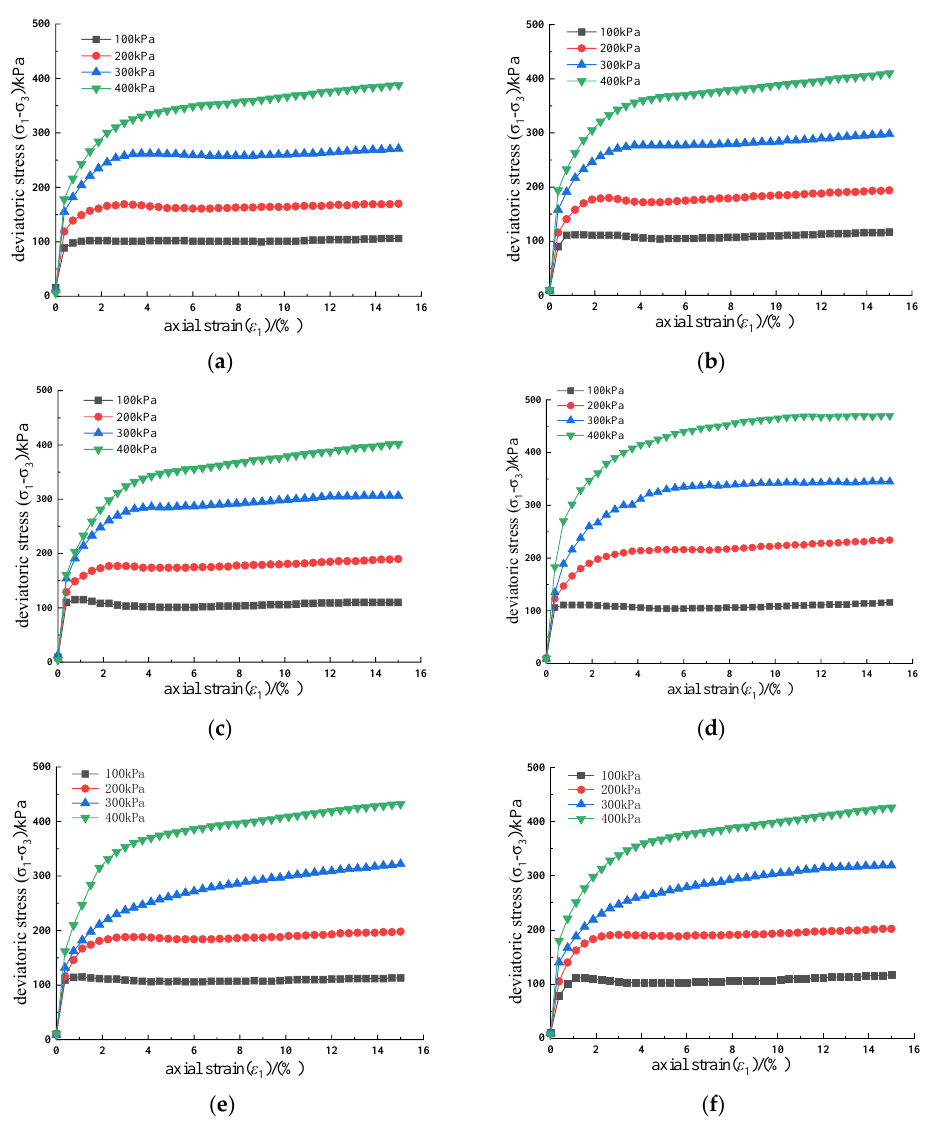
Figure 5. Relation curve between principal stress difference and axial strain. ( a ) 0% coir fiber; ( b ) 0.2% coir fiber; ( c ) 0.25% coir fiber; ( d ) 0.3% coir fiber; ( e ) 0.35% coir fiber; ( f ) 0.4% coir fiber.